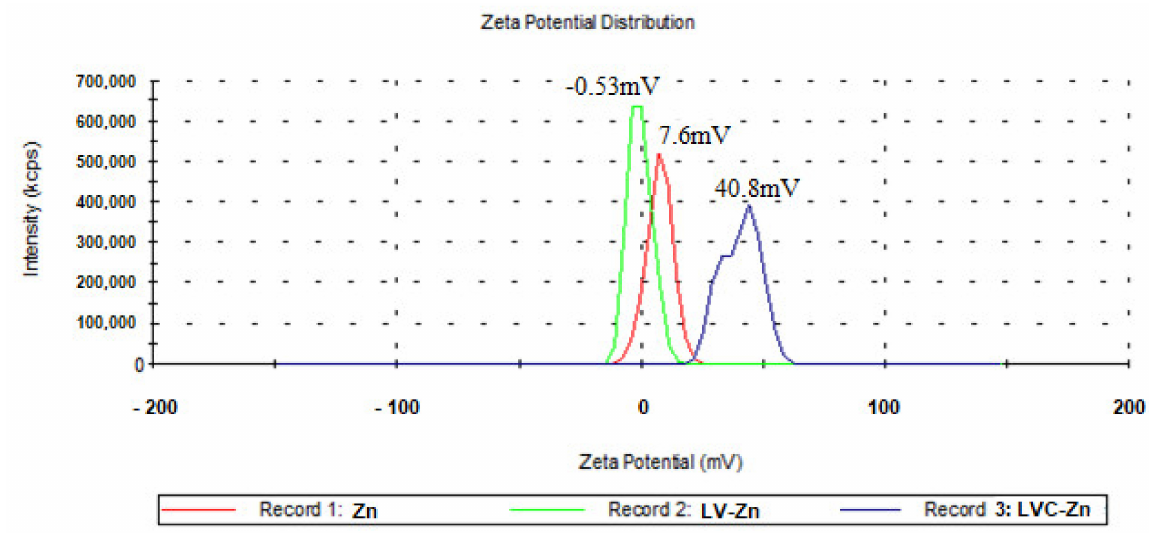
Figure 2. Distribution of the Zn vesicles’zeta